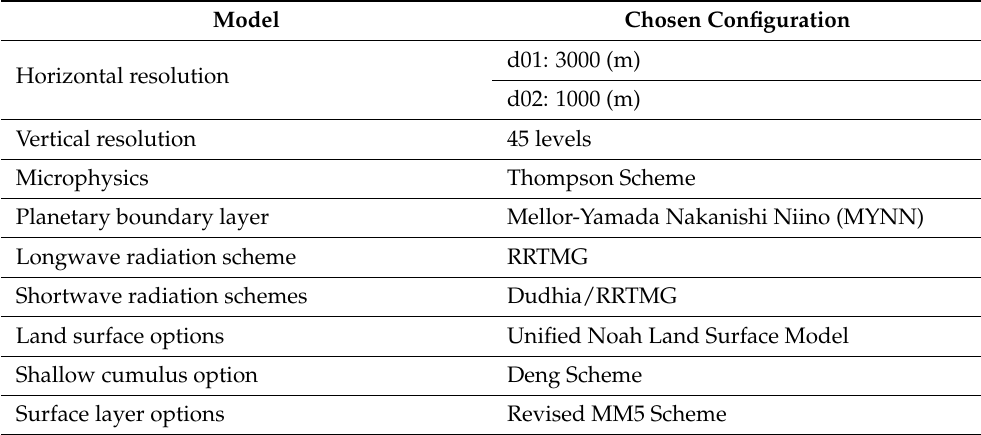
Table 2. WRF physics option